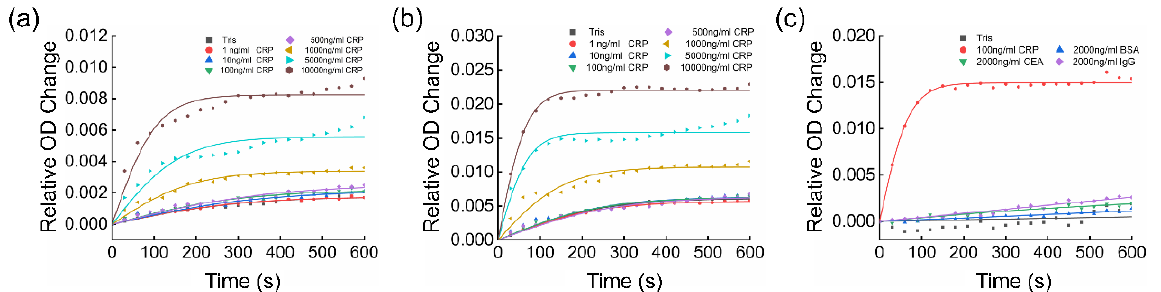
Figure 5. Plots of the relative OD change at ( a ) 600 nm and ( b ) 340 nm in regular immunoturbidimetry assay of CRP samples in a regular microplate without integrated nanosensor chips. ( c ) Plot of the relative OD change at the resonant wavelength 600 nm using NanoPITA for the CRP, BSA, CEA and IgG in a microplate with integrated nanosensor chips.